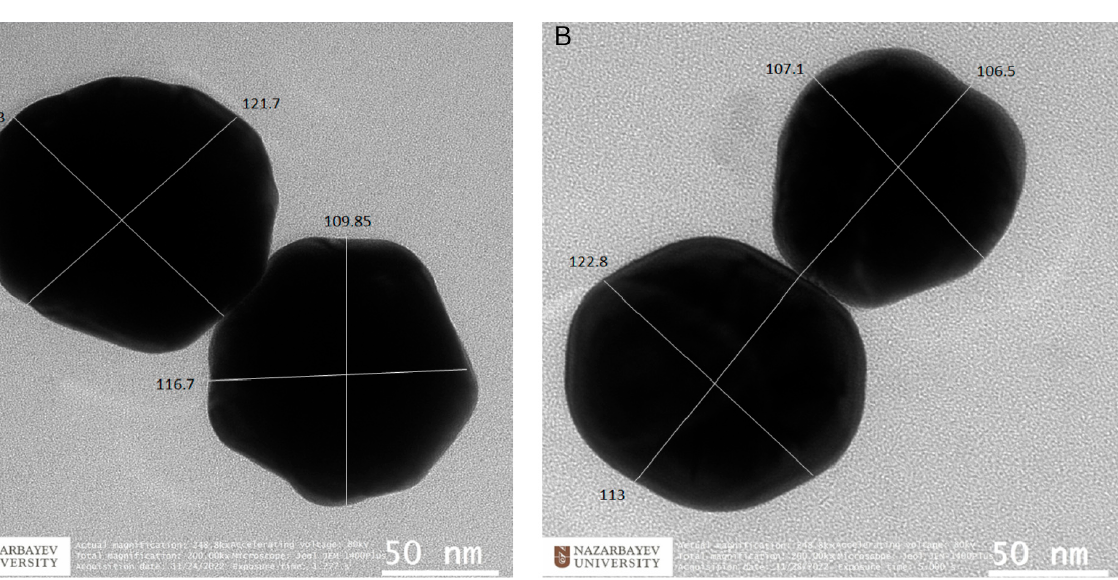
6 of 17 Figure 2. SEM pictures of 100 nm Ag NPs and 100 nm Au NPs on the silver substrates. ( A ) The SEM image of 100 nm Ag NPs with a magnification of 50,000. ( B ) The SEM image of 100 nm Au NPs with